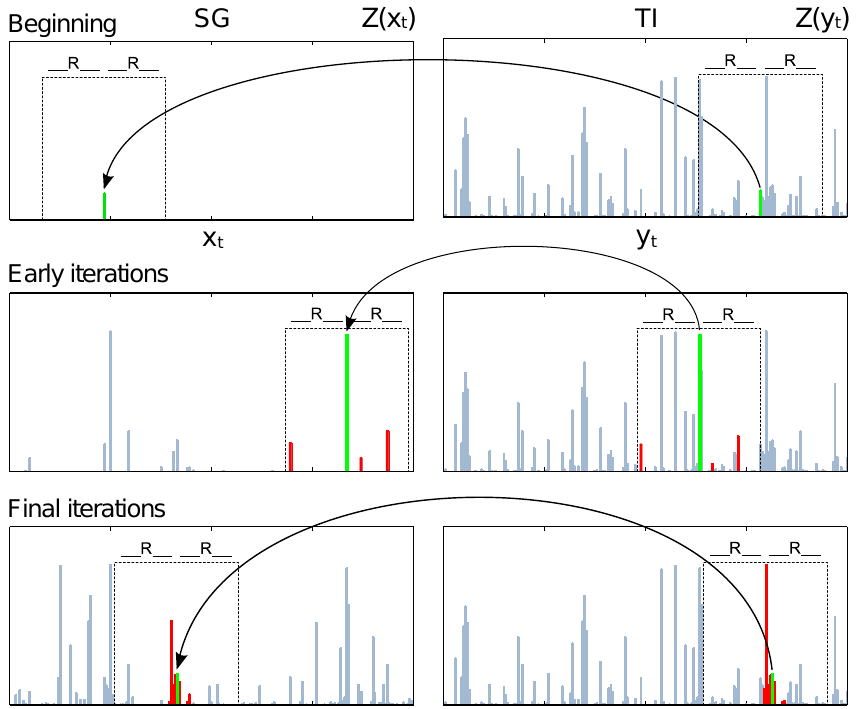
Figure 1. Sketch of the sequential simulation of a rainfall time series performed by the direct sampling technique: the dashed rectangle represents the search neighborhood of radius R , the datum being simulated is in green and the ones composing the data event are in red. Note the nonexact match between the data event in the SG and the one in the TI.